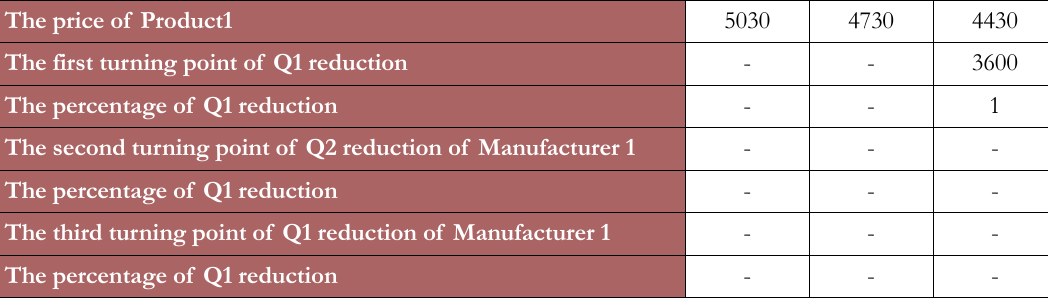
Table 7. The change of Q1 with the change of Lenovo and HP computer prices